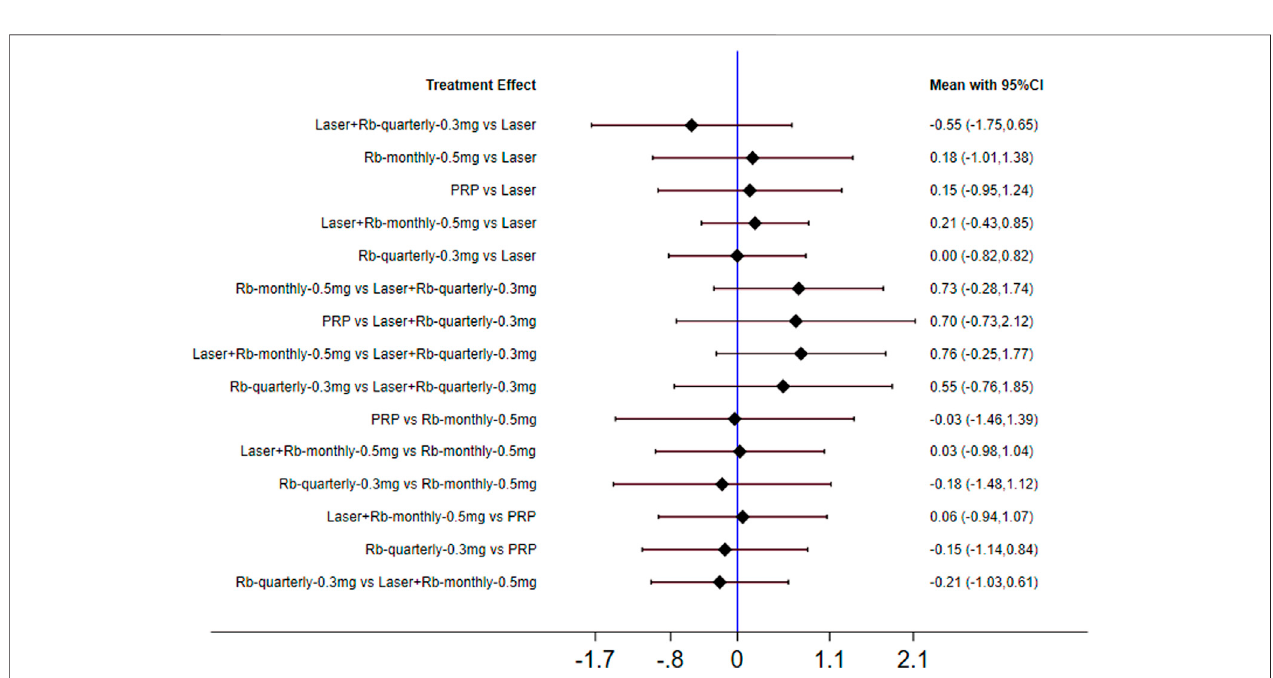
FIGURE 4 | Forest plots for subgroup analysis of vision score change. Horizontal lines indicate the range of 95% CI. Abbreviation: Ranibizumab (cid:1) Rb.